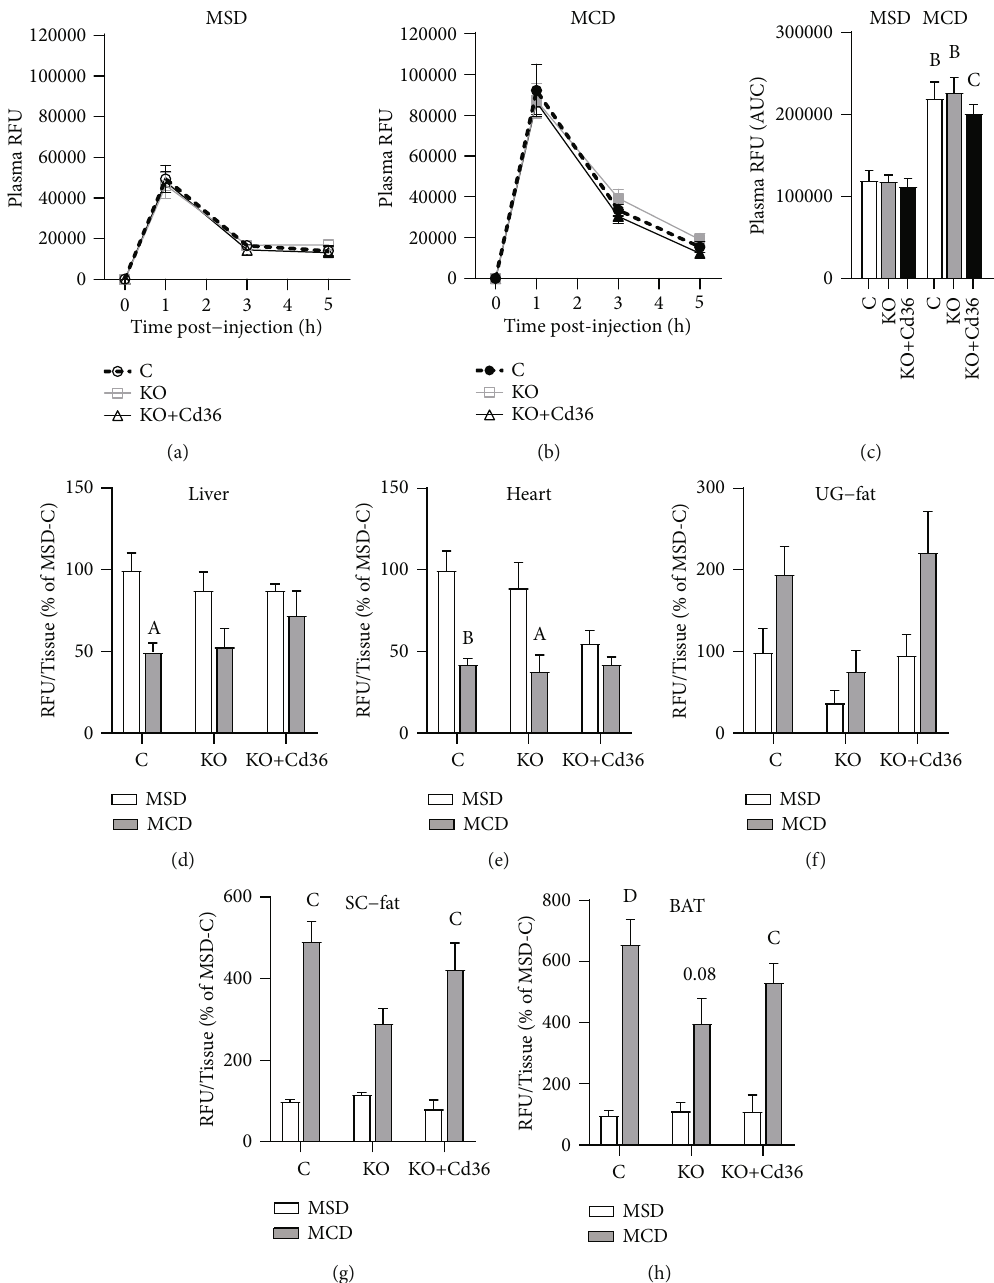
Figure 3: MCD diet reduced hepatic fatty acid uptake but increased fatty acid uptake in adipose tissue. Plasma BODIPY-C16 levels in mice fed (a) MSD diet or (b) MCD diet. (c) Area under the curve of plasma BODIPY-C16 levels. (d) Liver-, (e) heart-, (f) urogenital (UG) fat-, (g) subcutaneous (SC) fat-, and (h) brown adipose tissue- (BAT-) speci fi c uptake of BODIPY-C16. RFU: relative fl uorescence units. Values of RFU/tissue are represented as the percentage of control mice fed a MSD diet (e – h). Letters represent signi fi cant di ff erences between MSD and MCD within groups. A p < 0 : 05 ; B p < 0 : 01 ; C p < 0 : 001 ; D p < 0 : 0001 . Control mice (C); Pparg Δ Hep mice (KO); Pparg Δ Hep mice with hepatocyte Cd36 overexpression (KO+Cd36). MSD diet: open columns, open symbols; MCD diet: close columns, close symbols. In (a – c), control mice (open columns, discontinuous lines), KO mice (grey lines and columns), and KO+Cd36 mice (black lines and columns). n = 4 ‐ 7